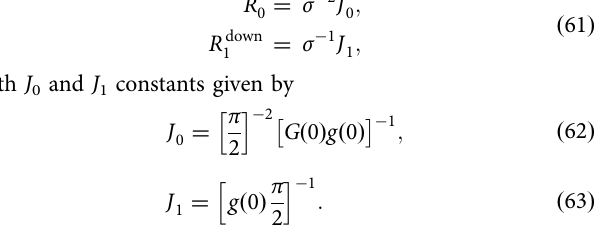
¼ R down ¼ 0 0 1